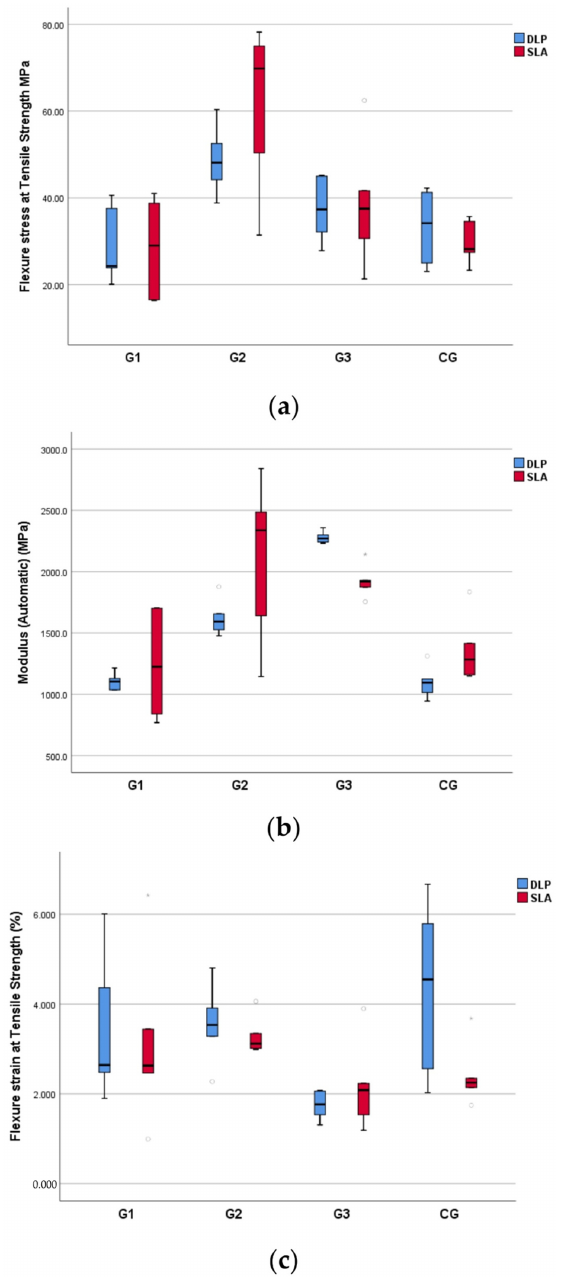
Figure 4. Boxplots of minimum, maximum, interquartile range, median, and outliers for standard specimens (CG–G3) during the flexural test: flexural modulus of elasticity ( a ); flexural strength ( b ); flexural strain ( c ). Table 2. Flexural strength, flexural strain, and flexural modulus of elasticity values of the DLP- and SLA-printed